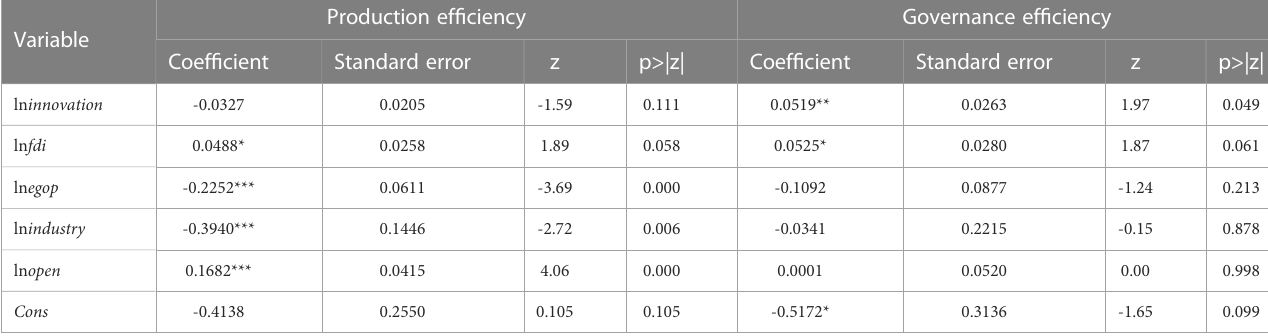
TABLE 6 Tobit regression results of marine green economy ef fi ciency at different stages.